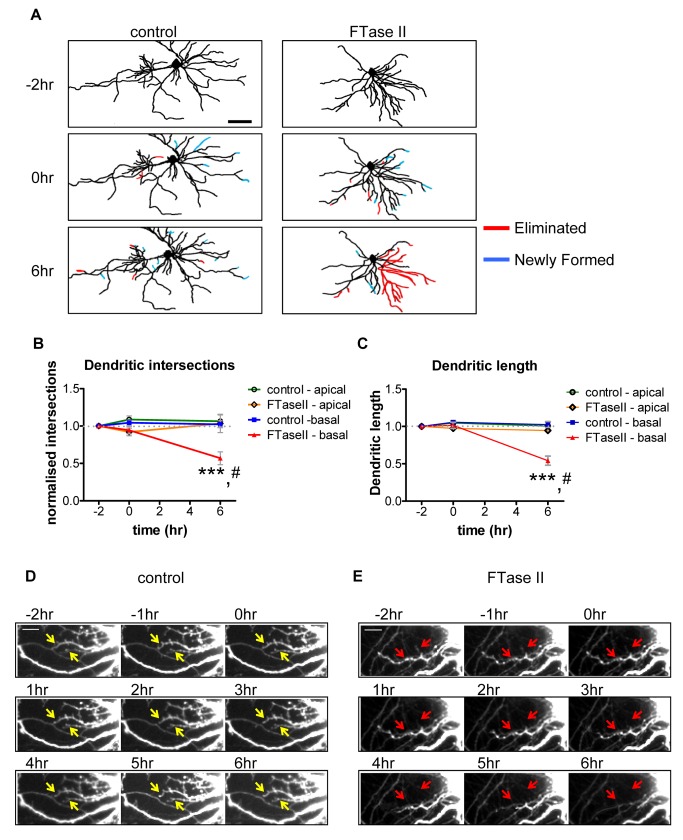
Ras inhibition induces basal dendrite retraction.(A) Binary image of basal dendrites of live-imaged cells at time points −2, 0, and 6 h of FTaseII (200 nM) or vehicle treatment. Cyan lines indicate newly formed dendrites; red lines indicate eliminated dendrites. Under control conditions, loss and gain of dendrites remains constant over imaging period. Treatment with FTaseII results in a dramatic loss of basal dendrites after 6 h of treatment. (B–C) Quantification of apical and basal arbor complexity (B) and apical and basal dendritic length (C). Data are normalized to −2 h time point. *, difference between control and FTaseII condition; #, difference between time points. (D–E) Frame-by-frame montage of basal dendrite stability under control (vehicle-treated) conditions (D; white arrows indicate stable dendrites), or of basal dendrite retraction following FTaseII treatment (E; red arrows indicate retracting basal dendrite). #, ***p<0.001; scale bars, 100 µm (A), 10 µm (D, E).